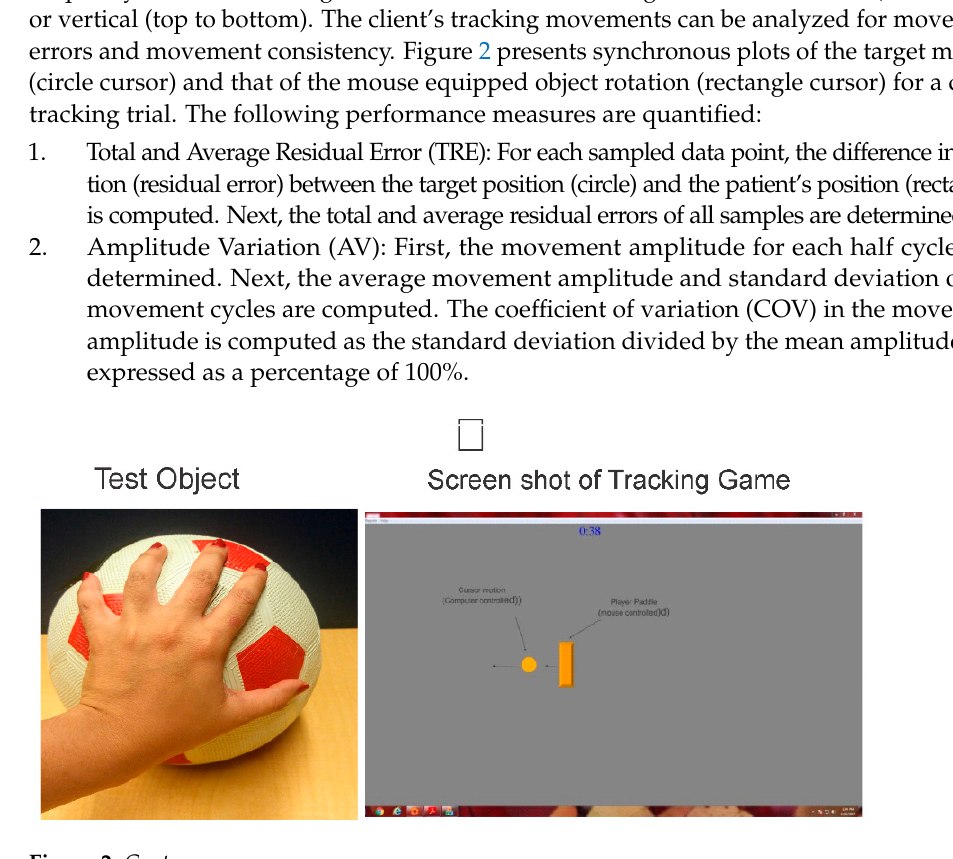
Figure 2. Illustration of an assessment using the cyclic tracking module. In this case, the RMD handle manipulation requires fine rotation using abduction-adduction and flexion-extension of the thumb and fingers. Top right panel shows a screenshot of the tracking task, goal is to track and overlap the game paddle (rectangle object with the moving circle object (computer controlled)). Bottom plots show typical movement trajectory of a healthy young adult performing the tracking task. It is played for 30 s to obtain several continuous tracking cycles for analysis. Note the first two cycles are not included in the computation of either TRE or AV, as it often takes one or two cycles for the subject to begin the tracking task. 5. Motor Skill Game (MSG) Module This module requires the client to interact with various moving game objects. As il- lustrated in Figure 3, the game objects appear at random locations on the computer screen. The patient manipulates the object to control the motion of the game paddle that interacts with the moving game objects. For example, a typical game is played for 60 s, and the duration of each game event (from object appearance to its disappearance) can be set to 2 s. In this case, the patient makes 30 goal-directed game movement responses. These con- textual game movement responses can be analyzed for success rate, response time, move- ment time, accuracy, and movement variation. In addition to target objects that are to be tracked and caught, there are distractor objects that must be avoided. Distractor objects can be turned off depending upon the required complexity of the game, or cognitive pro- cessing load. Target and distractor objects appear at random locations of the display and move to the opposite edge of the monitor. There are many difficulty levels ranging from very easy to difficult; therefore, it can accommodate individuals with all types of move- ment control. The following features and game elements are configurable: 1. Movement speed;